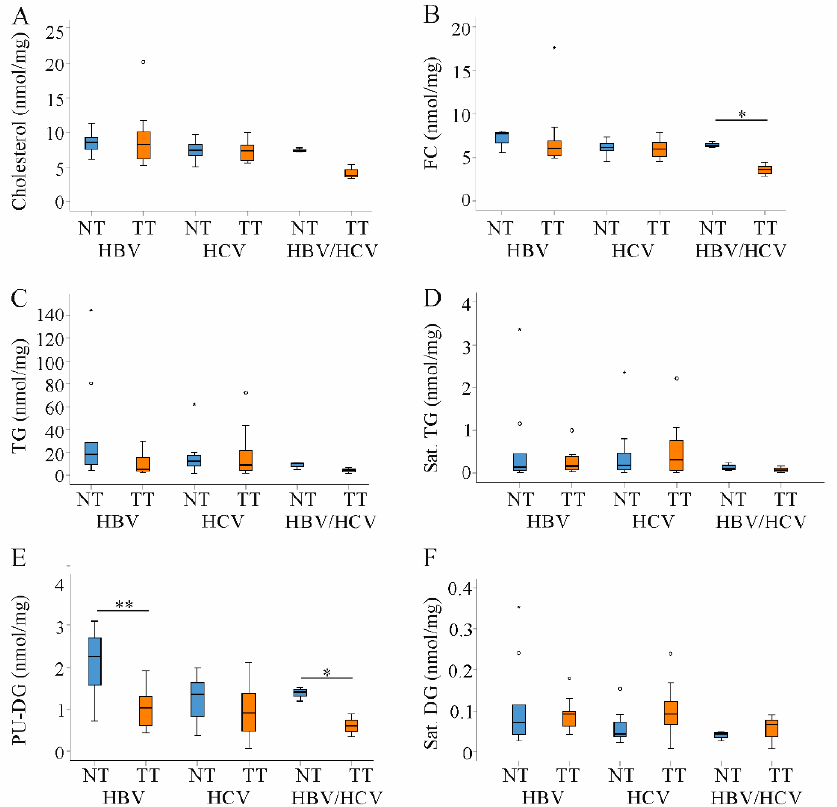
Figure 5. Cholesterol, triacylglycerols (TG) and diacylglcerols (DG) in non-tumor (NT, blue boxes) and tumor tissues (TT, orange boxes) of patients with HBV and HCV infection. ( A ) Cholesterol; ( B ) Free cholesterol (FC); ( C ) TG; ( D ) Saturated (sat.) TG; ( E ) Polyunsaturated (PU) DG and ( F ) Sat. DG in NT and TT of HBV, HCV and double infected patients. Small circles and stars in the figures identify outliers. * p < 0.05, ** p < 0.01 (Kruskal-Wallis-Test).